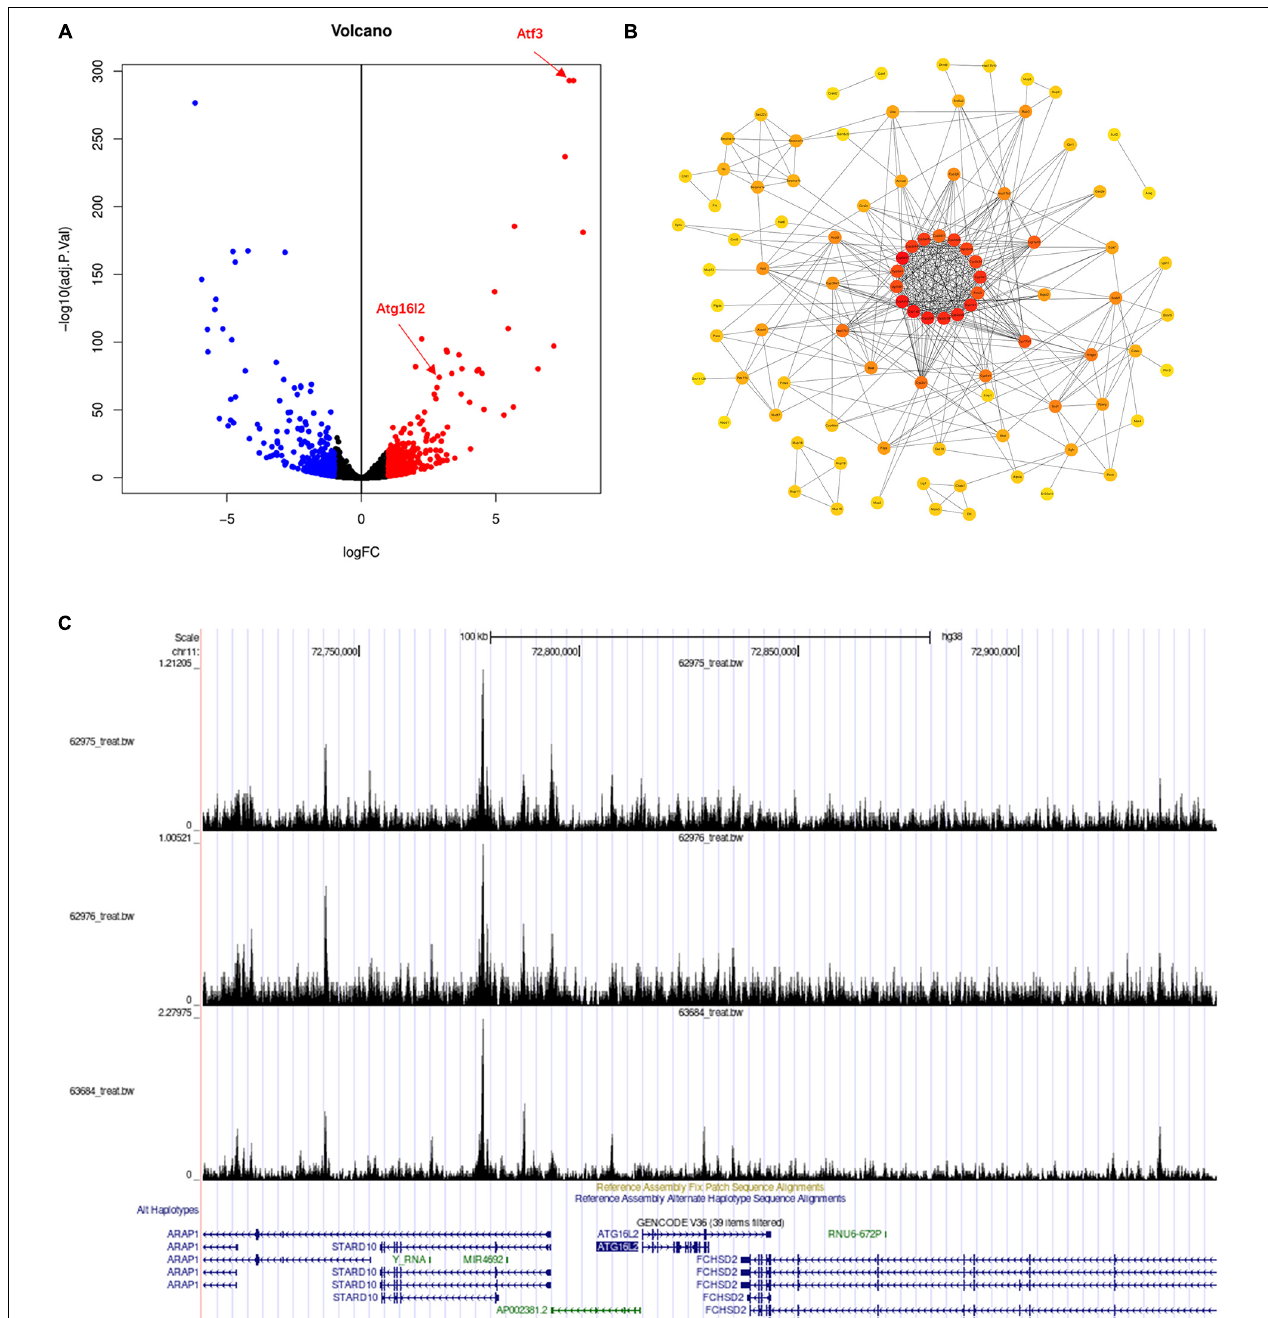
FIGURE 5 | Genes showed significant changes in mouse liver tissue overexpressing ATF3 compared to controls. We did a differential expression analysis of RNA-seq data from mouse liver tissue overexpressing ATF3 and controls. (A) The results showed 389 significantly upregulated genes and 315 downregulated genes including Atg16l2 . (B) PPI network of genes functioning in immune, endoplasmic reticulum, and mitochondria-related signaling pathways. (C) The peaks in the genomic region of human gene ATG16L2 from ATF3 ChIP-seq data in the ENCyclopedia of DNA